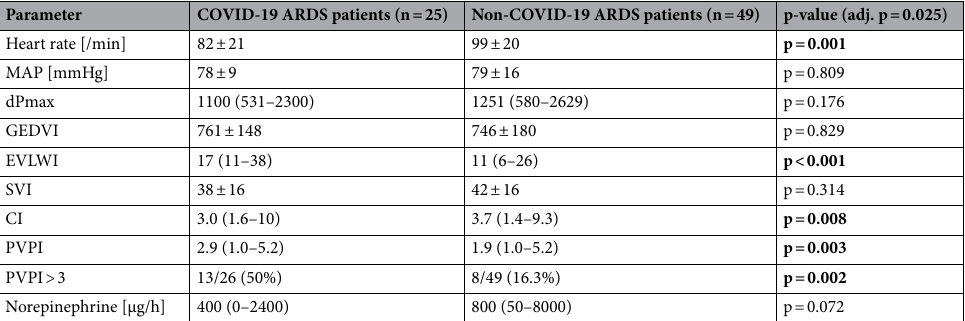
Table 3. Initial (at intubation) measurement of hemodynamic data. MAP mean arterial pressure, dPmax cardiac contractility index, GEDVI global end-diastolic volume index, EVLWI extra vascular lung water